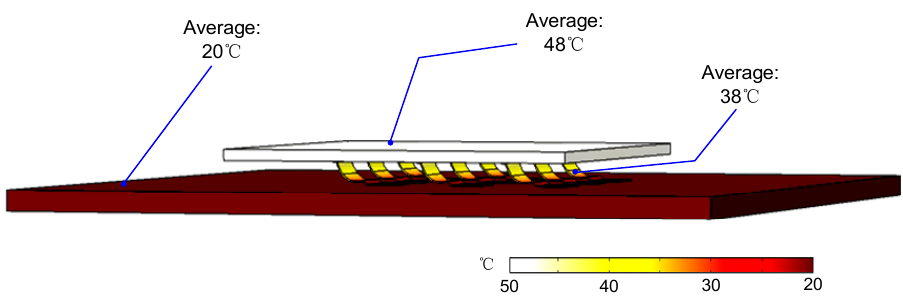
Figure 13. Temperature distribution of the 3 × 3 CMI array with Multiphysics simulation.